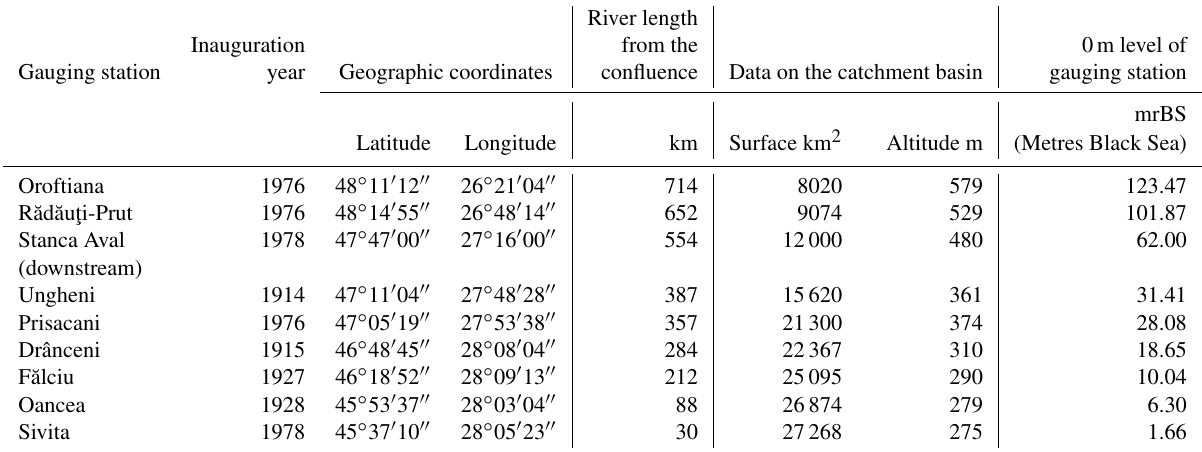
Table 2. Morphometric data for the gauging stations on the Prut River (Romania).